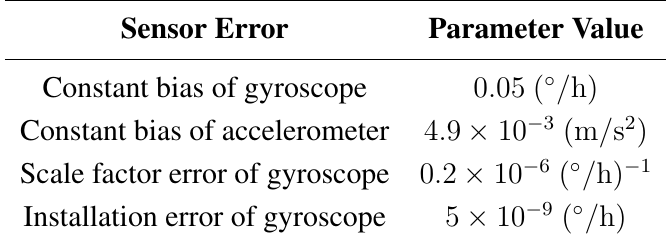
Table 2. Inertial sensor performance (Group 2).